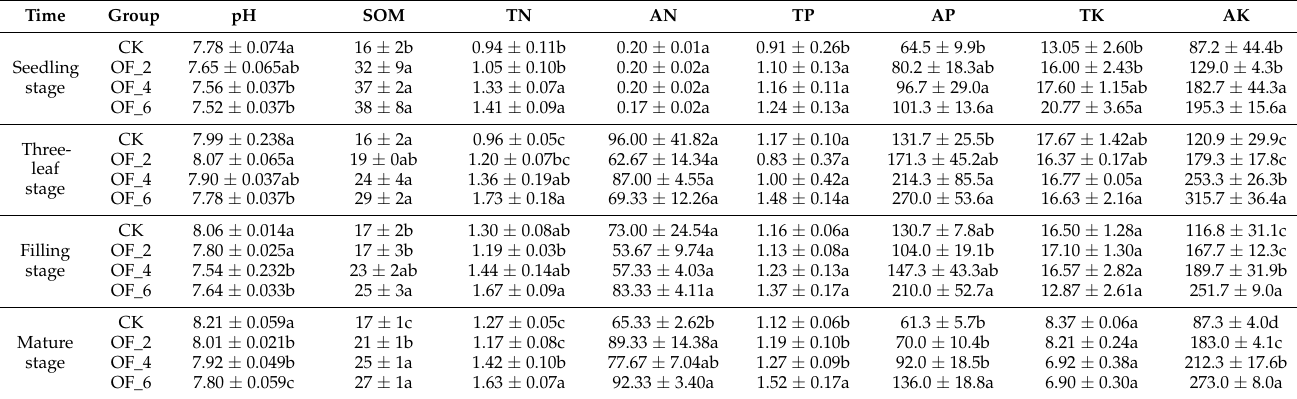
Table 1. Effect of organic fertilizer application rate on soil nutrients. Units: